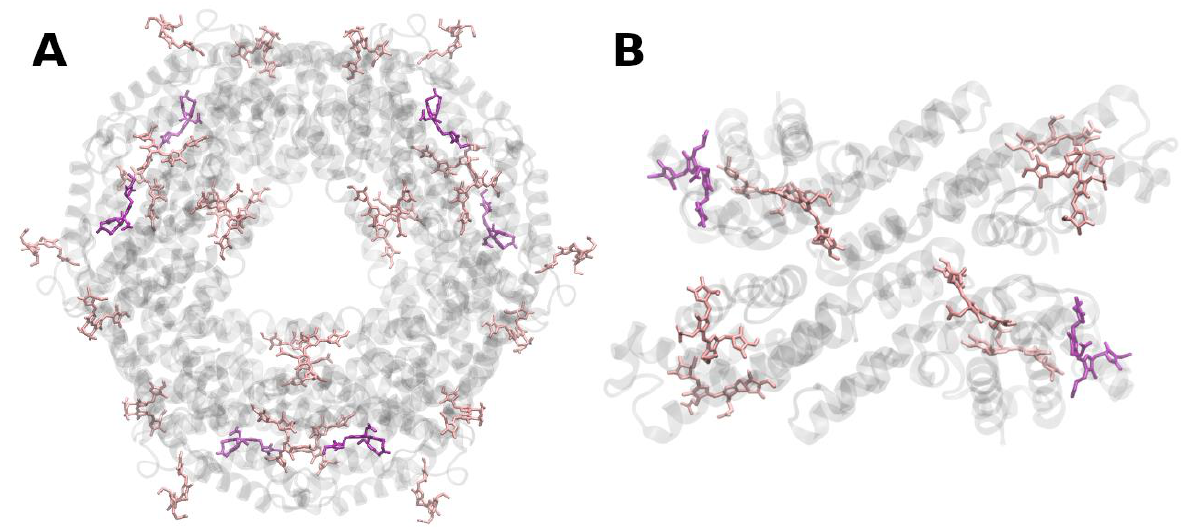
Figure 10. Structure of phycoerythrin from Gloeobacter violaceus at 2.19 Å resolution, PDB entry 2VJH [4]. ( A ) View of the dodecamer along the phycobilisome stacking axis. ( B ) Side view of a tetrameric unit, perpendicular to the stacking axis. The protein backbone is shown in grey. Phycoerythrobilins are shown in pink, phycourobilins in violet.